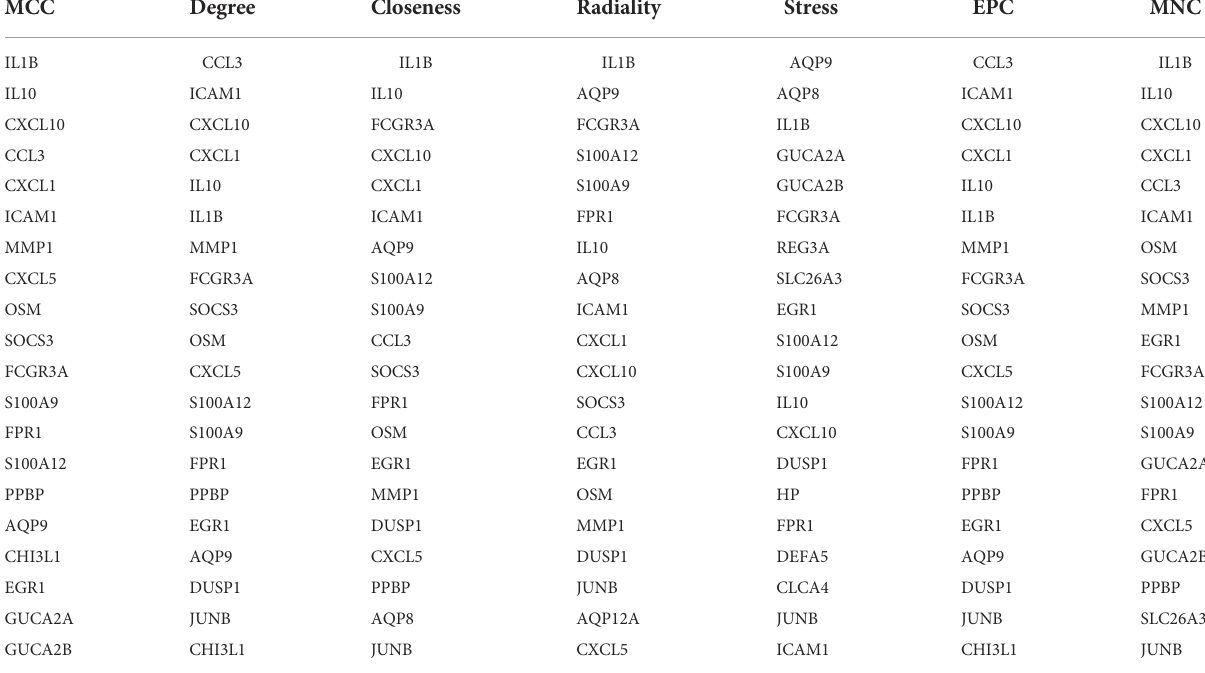
TABLE 1 Top 20 hub genes in seven